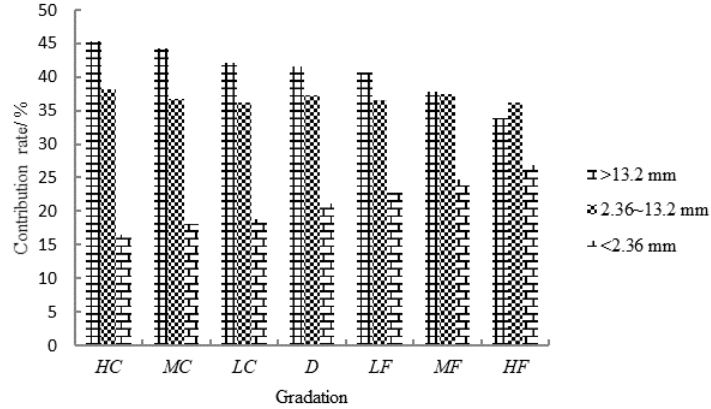
Figure 13. Contribution rate to load resistance for aggregates with different particle sizes.